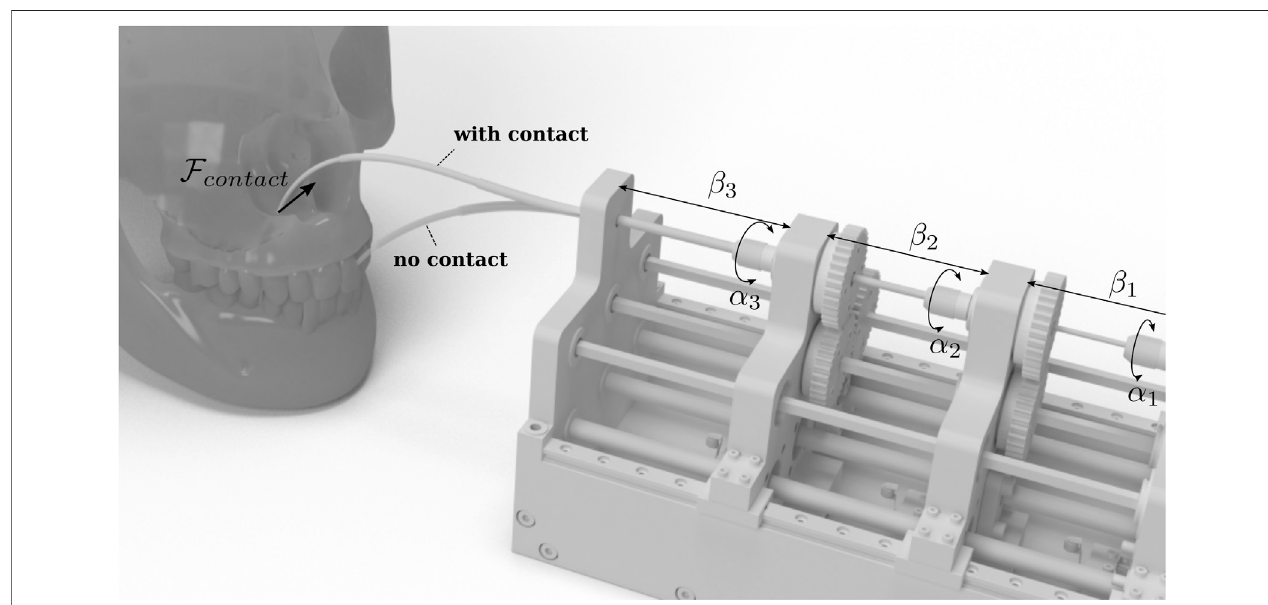
FIGURE 1 | CTRs are especially interesting for medical applications. A major challenge in this area is shape and force estimation. The fi gure shows a typical actuationunitwithtubeswithoutexternalforces(fadedtubes)andinacontactsituation.Calculatingthechangeinthetubes ’ shapeduetothosecontactseitherbydirect measuring or estimation is the main task of shape sensing and shape estimation,